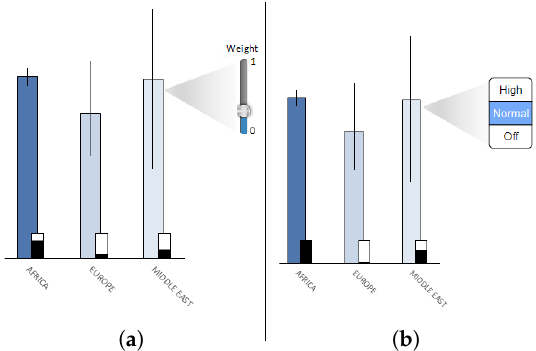
Figure 8. Two methods of controlling sampling rates in the progressive visualization. Our initial designs proposed a slider for fine granularity ( a ). Based on our findings from our user study, we refined the controls to be three buttons: High, Normal and Off ( b ). Users generally only used three positions of the slider and did not need fine grained control of sliders.